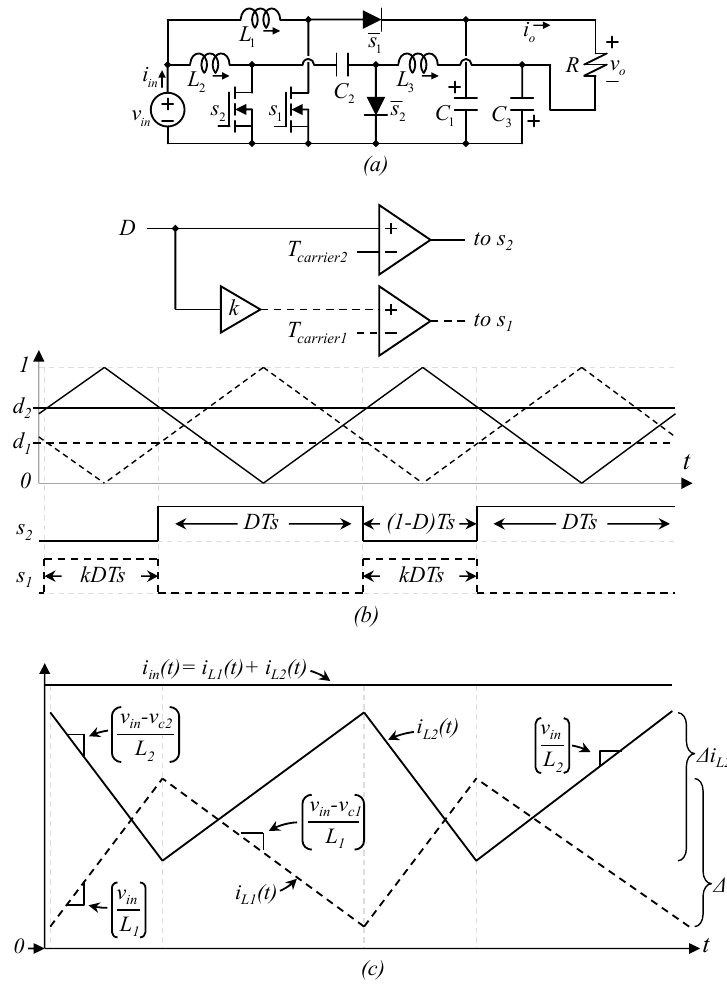
Figure 3. The hybrid converter proposes in [5], ( a ) topology, ( b ) switching functions generation strategy and waveforms related to the PWM, ( c ) important waveforms related to the input current ripple.